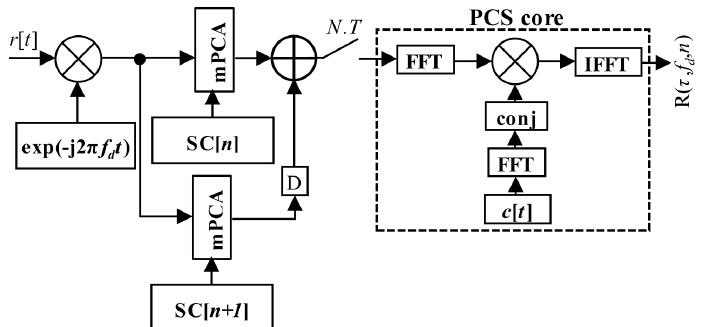
Figure 19. Proposed mPCA mSBZP schema for SC acquisition in the pre-correlation processing algorithm .